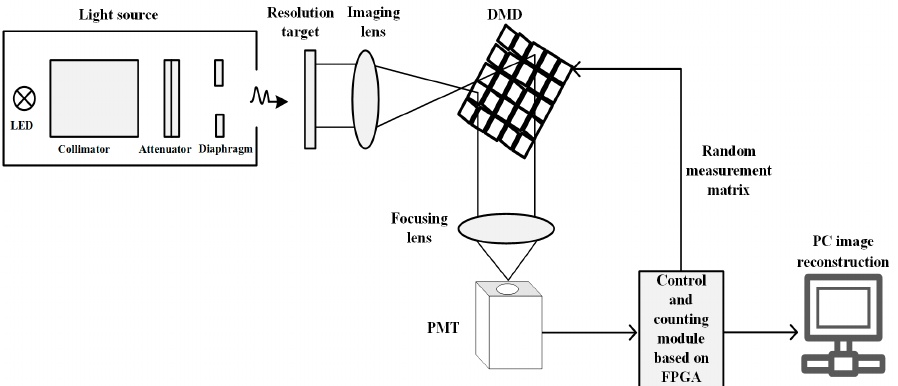
Figure 1. Schematic diagram of single photon compressive imaging system, including a light source, a resolution target, an imaging lens, the digital micromirror device (DMD), a focusing lens, the photomultiplier tubes (PMT), the specially designed circuit for the control of the DMD and counting photons synchronously, and a computer for image reconstruction.